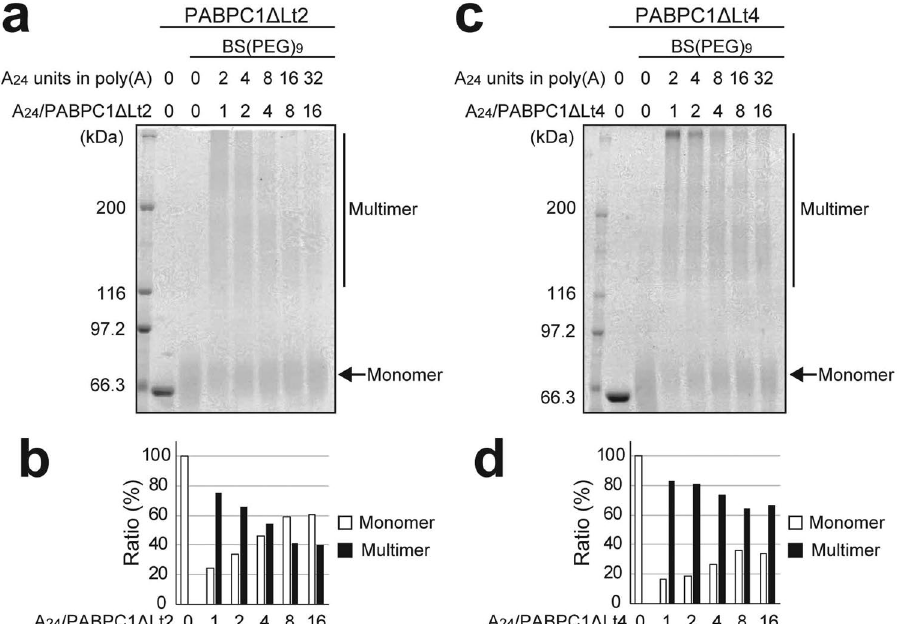
Figure 6. Chemical cross-linking of the poly(A)-bound PABPC1 Δ Lt2 and PABPC1 Δ Lt4. ( a , c ) SDS-PAGE analysis of the PABPC1 Δ Lt2 ( a ) and PABPC1 Δ Lt4 ( c ) proteins after BS(PEG) 9 treatment at each poly(A) concentration. The ratios of the monomer and the multimer at each molar ratio for PABPC1 Δ Lt2 and PABPC1 Δ Lt4 are plotted in ( b ) and ( d ), respectively. The monomer and multimer ratios were calculated by dividing the band intensity of the monomer and the multimer by the total